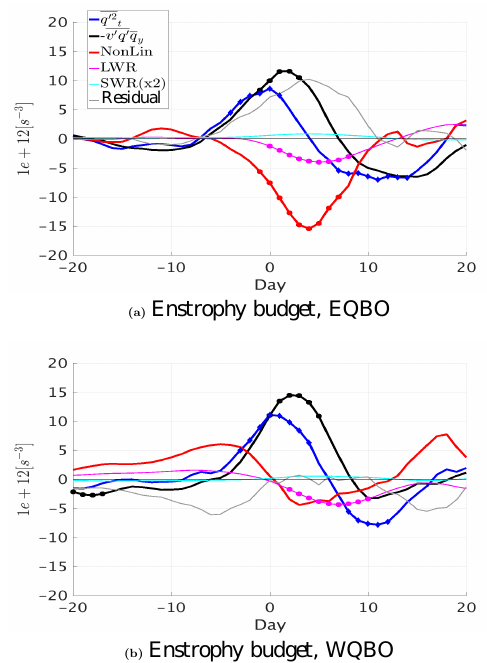
Figure 10. Time lag composite of the enstrophy budget terms (1 × 10 12 s − 3 ) for east (a) and west (b) QBOs, averaged over 70–40 ◦ N, 50–0.1mb, for the positive heat flux events from the 3DO 3 run of